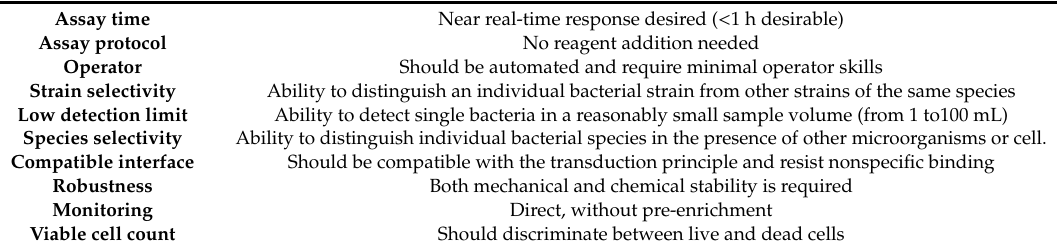
Table 1. Ideal properties incorporated for microbial